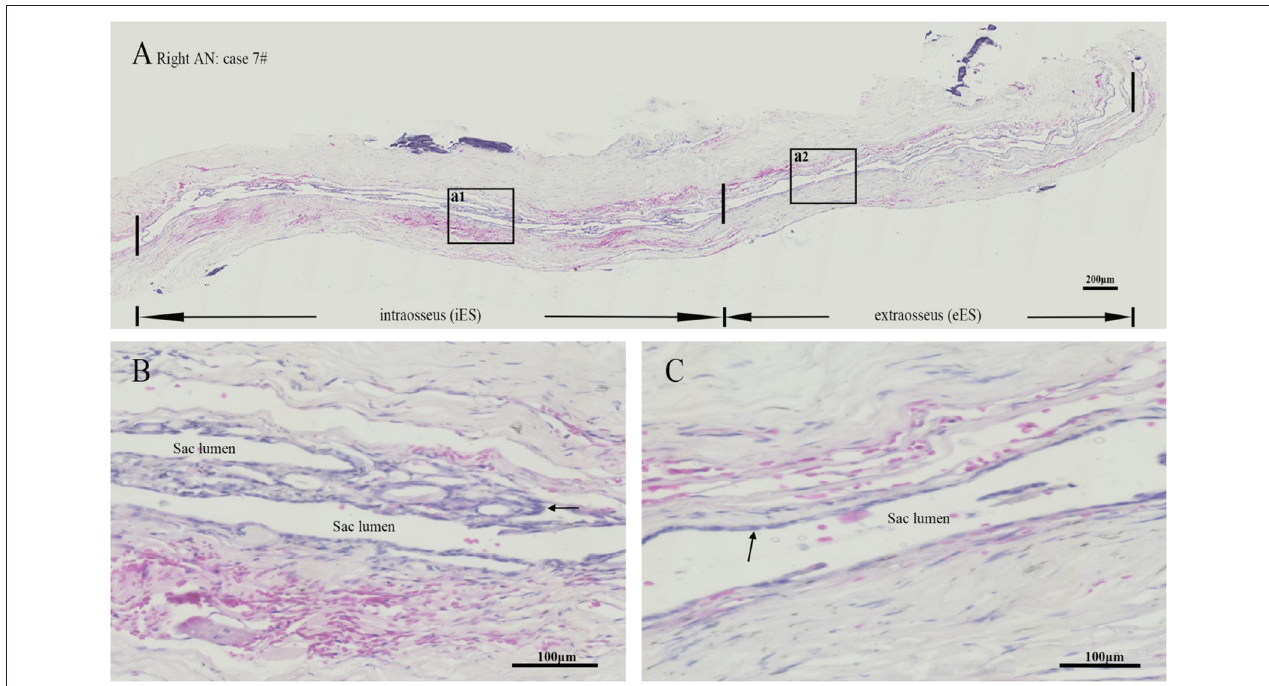
FIGURE 4 | Hematoxylin-Eosin staining revealed a lumen was patent or slit-like in the intraosseous and extraosseous portions of the ES from patient no. 7 with acoustic neuroma (A) , whereas the framed area of a1 in (A) magnified to show an intact folded epithelial (arrow) lining in the lumen of intraosseous part of ES (B) and the framed area of a2 in (A) magnified to show a simple cuboidal epithelium (arrow) lining in the lumen of extraosseous portion of the ES (C) . ES, endolymphatic sac. Scale bars: (A) 200 µ m; (B,C) 100 µ